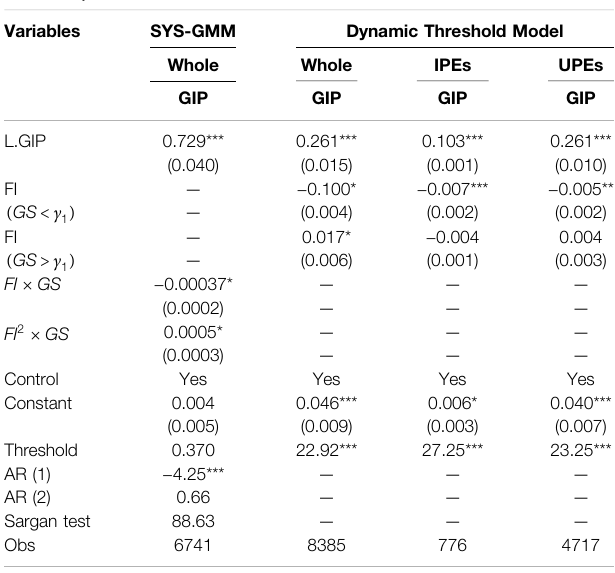
TABLE 7 | Robustness